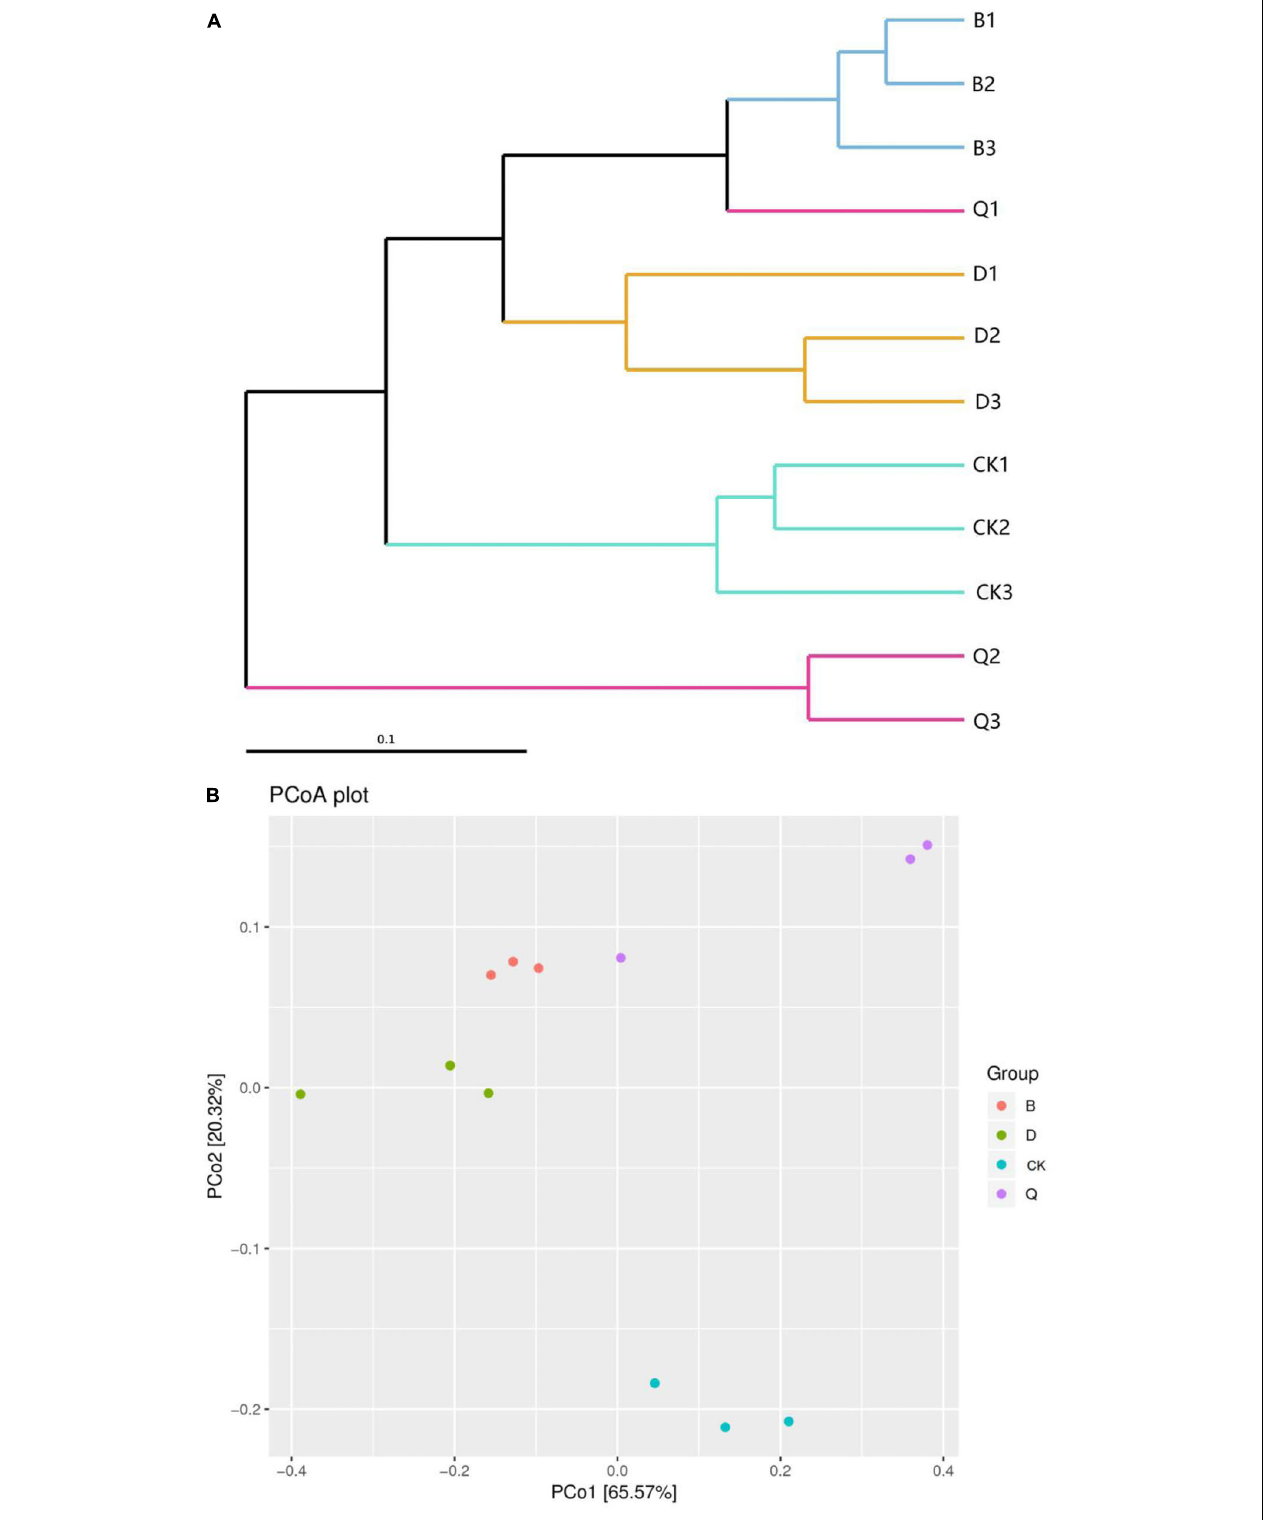
FIGURE 1 | Hierarchical clustering (A) and principal coordinates analysis (B) of fungal communities in tomato cropping substrate based on different treatments. Treatments B, D, and Q refer to crop rotation with Chinese cabbage, kidney bean, and celery, respectively. Control CK is continuous cropping with tomato.